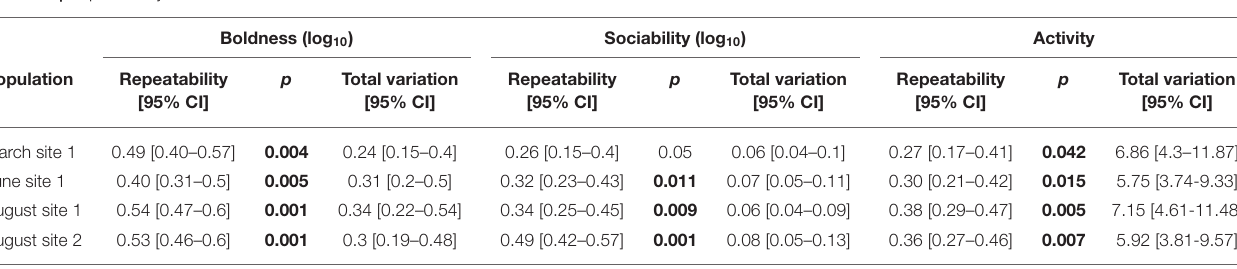
Table 2 ; for within- and among-individual variance estimates see Supplementary Table 5